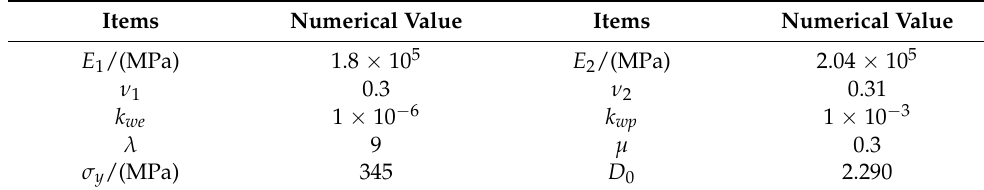
Figure 8. Schematic diagram of the pin-on-disc friction pair. Table 1. Friction parameters of the friction pair.